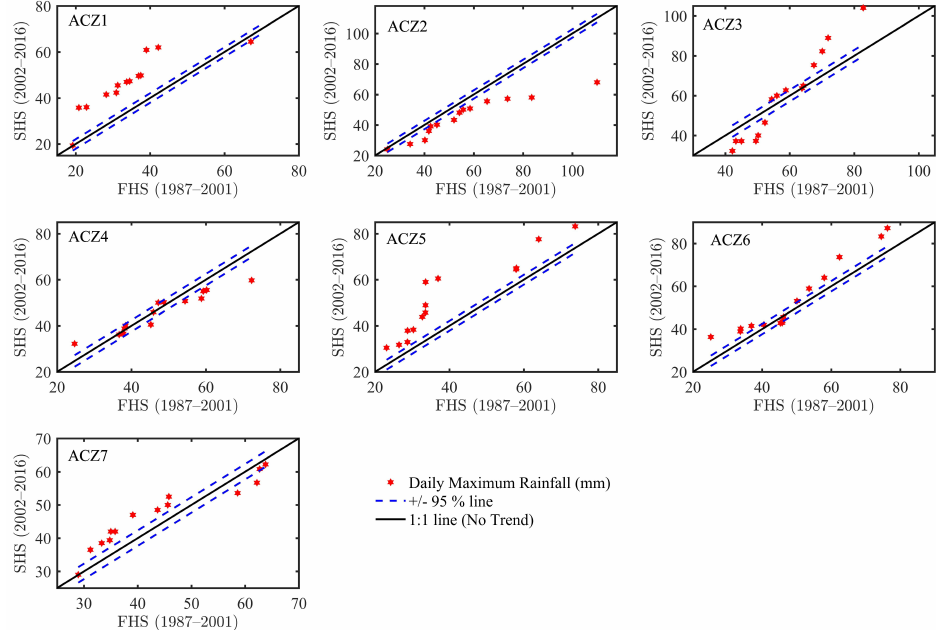
Figure 7. Daily maximum rainfall trend using the ITA method.